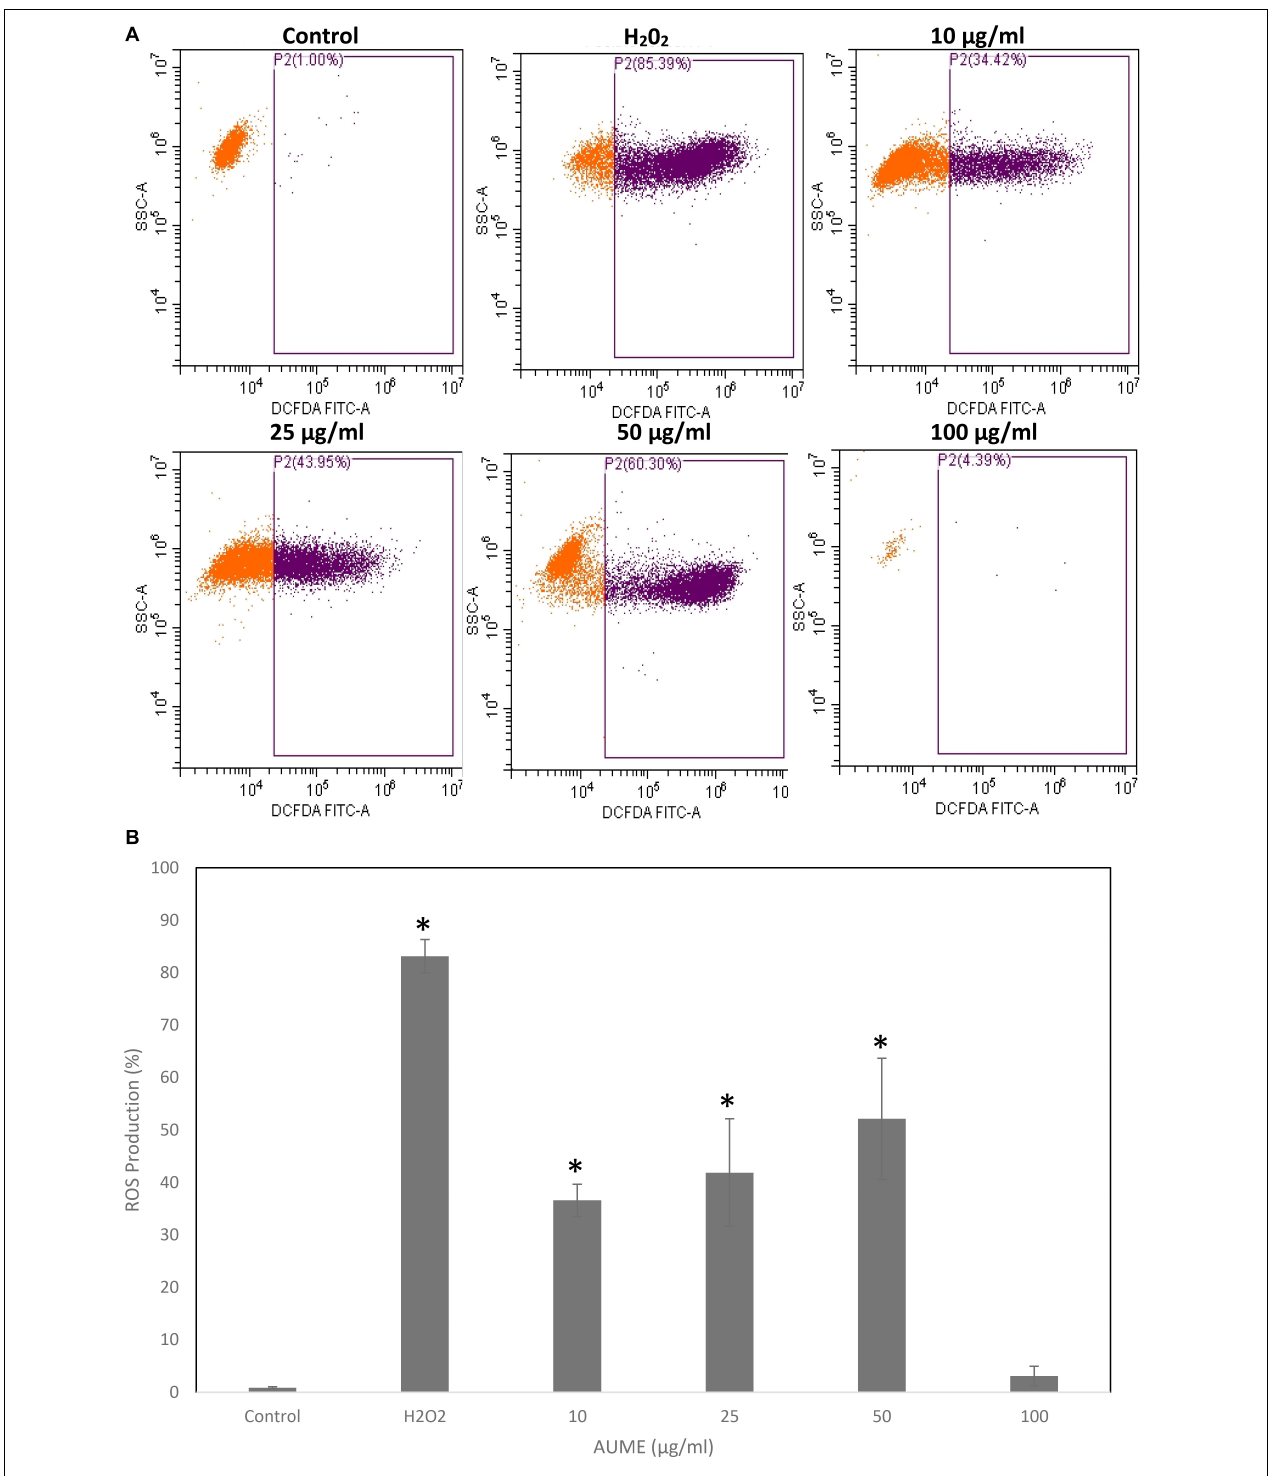
FIGURE 6 | (A) Intracellular ROS generation by AUME. HeLa cells were treated with indicated concentration of AUME for 48 h. DCFH-DA assay was performed to quantify the level of ROS by flow cytometry. (B) The bar diagram represents percentage of ROS produced in HeLa cells. Values are given as means ± SD of three replicates in each group, p < 0.05, *statistically significant when compared to